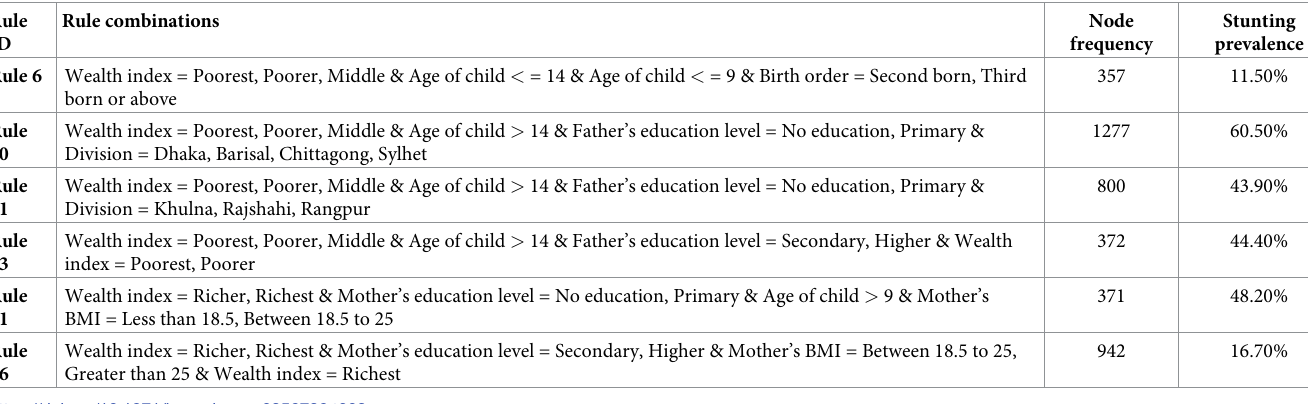
Table 2. Interaction rules extracted from the classification tree and associated